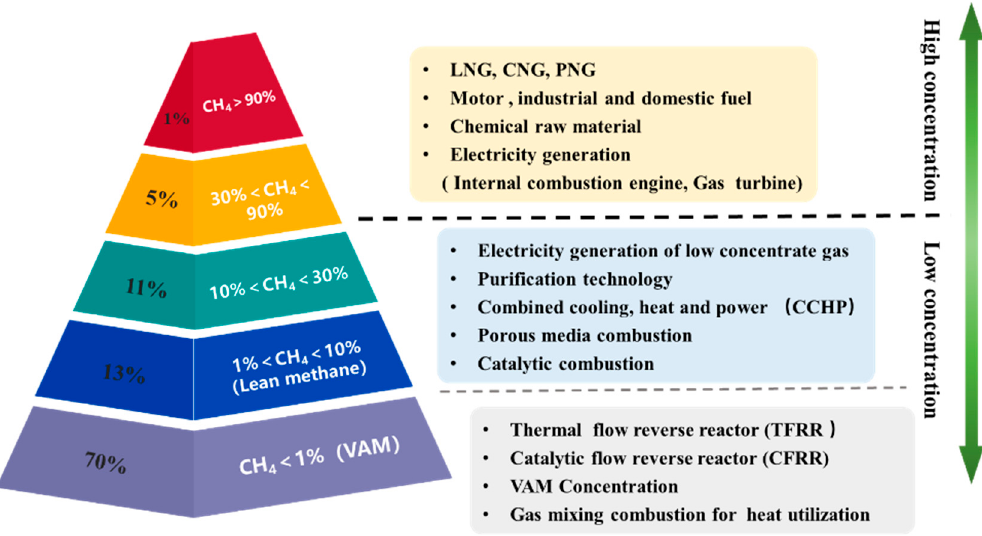
Figure 3. Utilization technologies of coal mine methane with different concentrations.